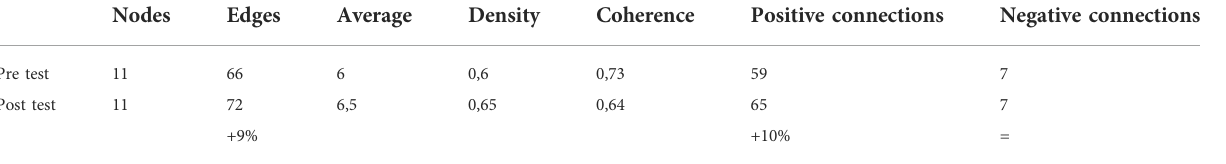
group organization dimension in the control group before the